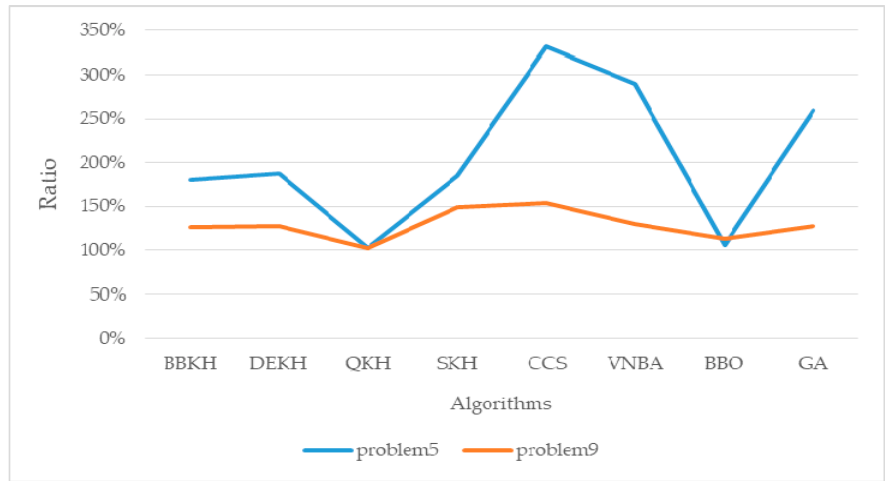
Figure 15. Ratio of AKQPSO over other algorithms in the third group.